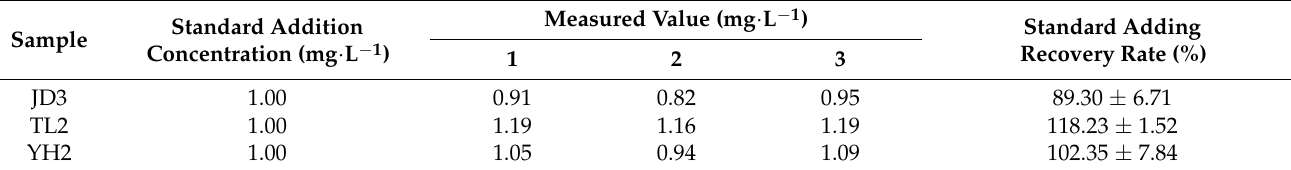
Table 7. Standard addition recovery test using the kit